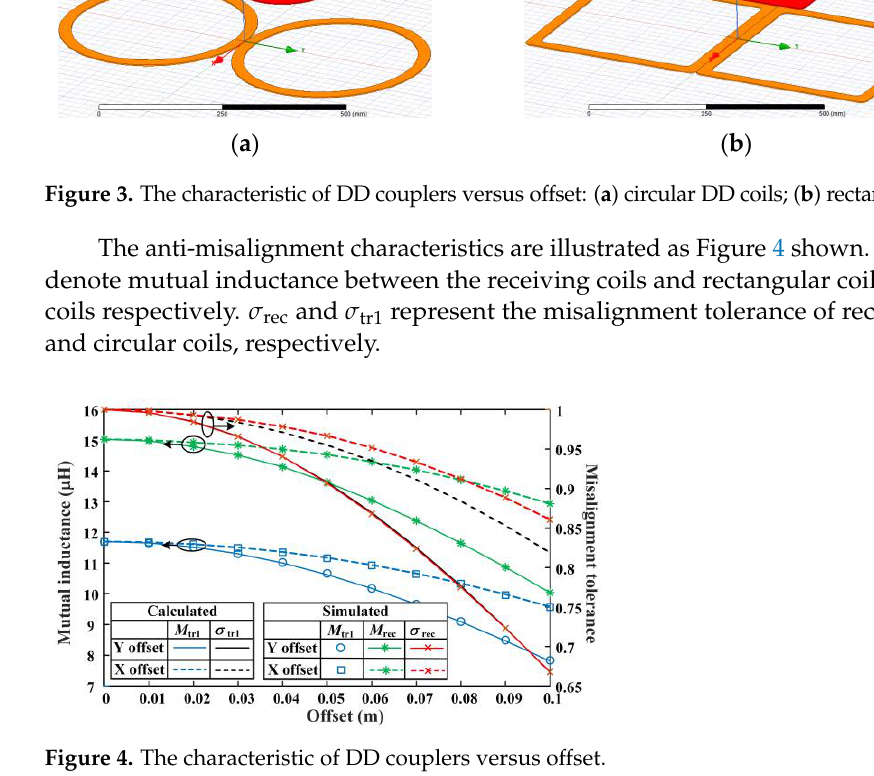
Figure 4. The characteristic of DD couplers versus offset.